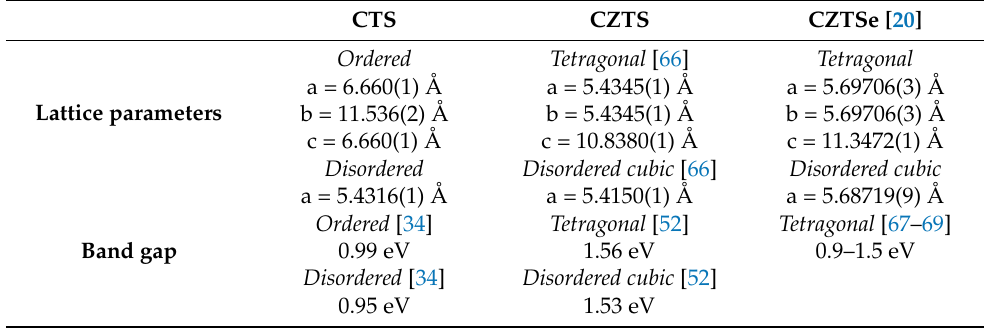
Figure 1. SR-XRD measurements on monoclinic ( a ), and cubic ( b ) Cu 2 SnS 3 polymorphs collected at 350 ◦ C. The zoomed images show the superstructure Bragg peaks (2 θ < 10 ◦ ) for monoclinic CTS phase representing (110), (11-1), and (021) reflections. These superstructure Bragg peaks are absent for the cubic CTS phase. The broad peak with diffused background at low 2-theta is due to the use of borosilicate glass for the dilution of samples. Table 2. Structural information and band gap values for the different polymorphs of CTS, CZTS, and CZTSe.